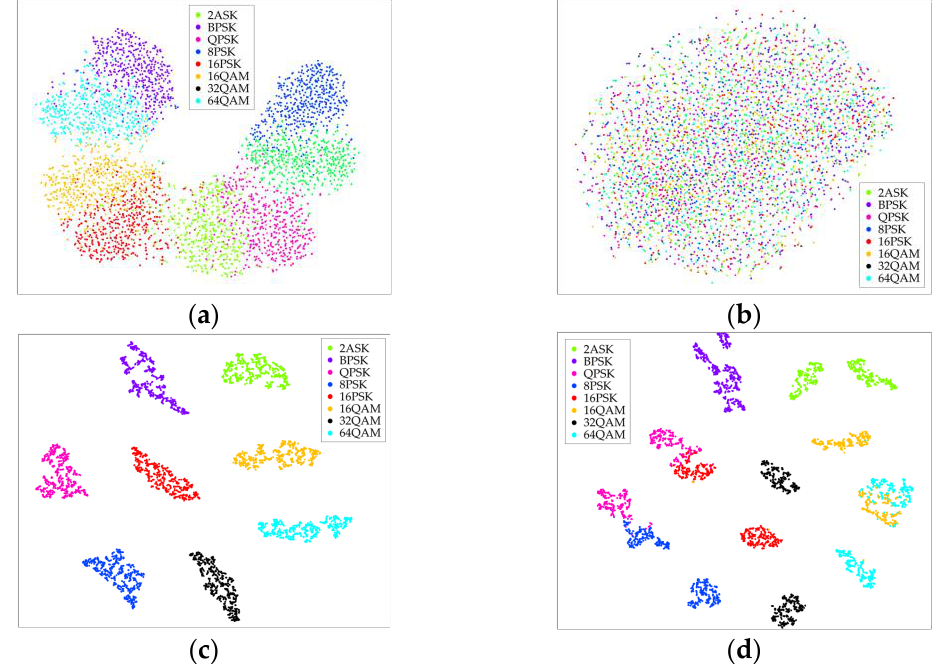
Figure 6. Feature visualization by t-SNE of CNN features on ( a ) source and ( b ) target datasets, and CNN-MK-MMD features on ( c ) source and ( d ) target datasets.